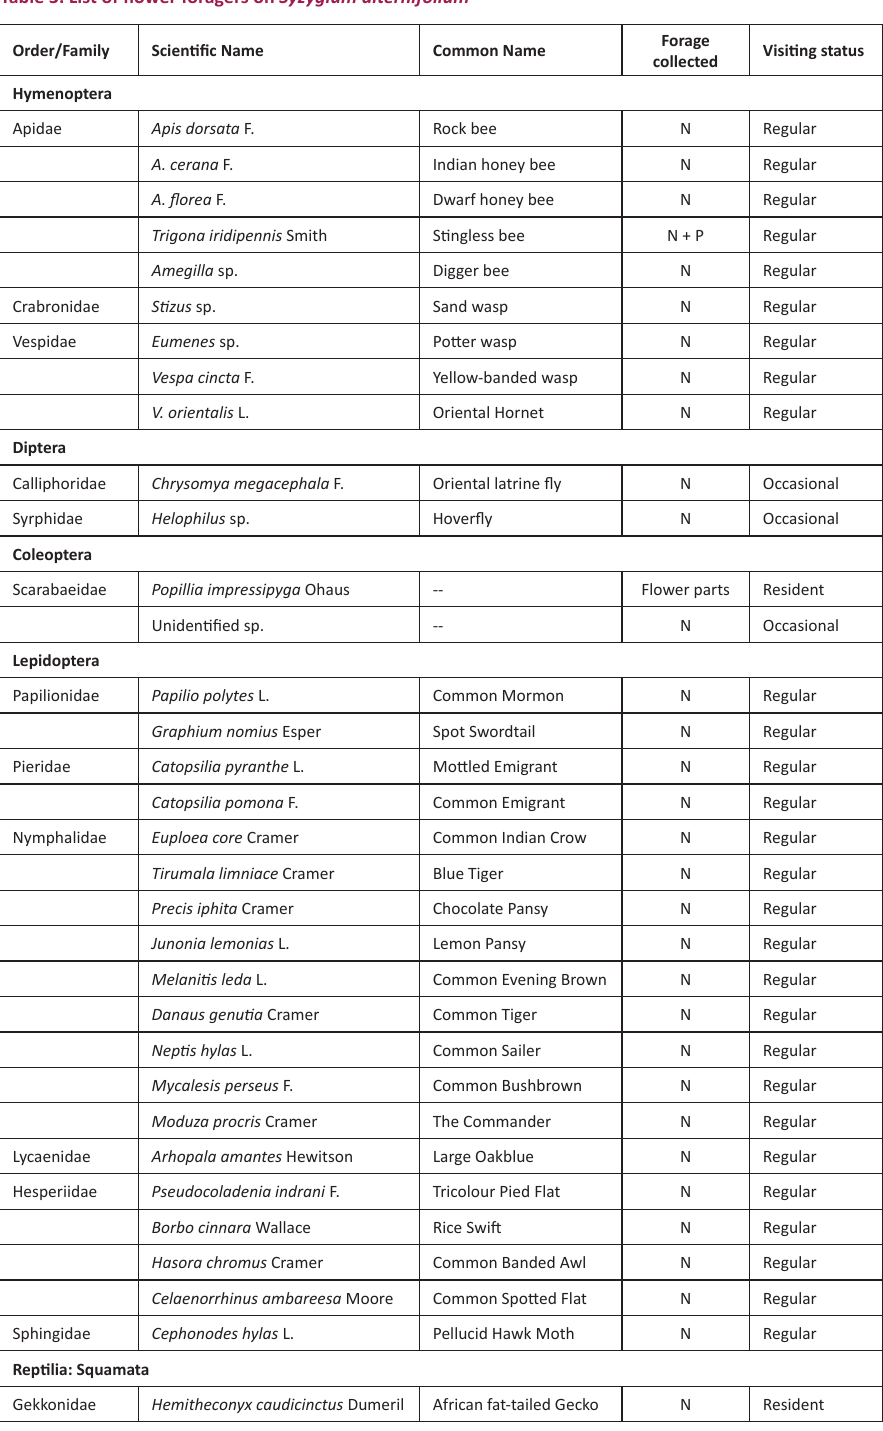
Table 3. List of flower foragers on Syzygium